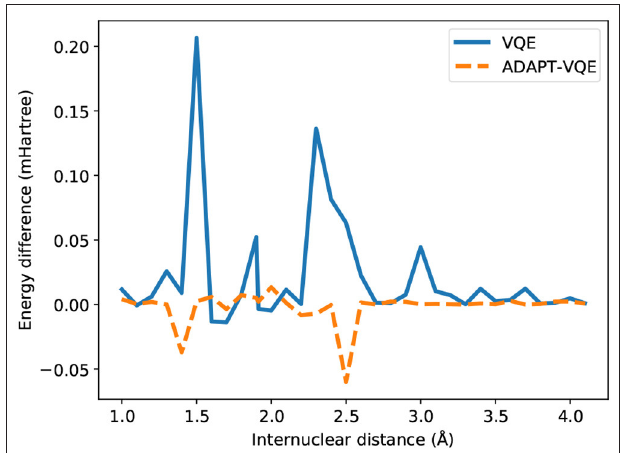
FIGURE 5 | Difference between the energies from COBYLA and L-BFGS optimization with central finite differences for the NaH potential energy curve.